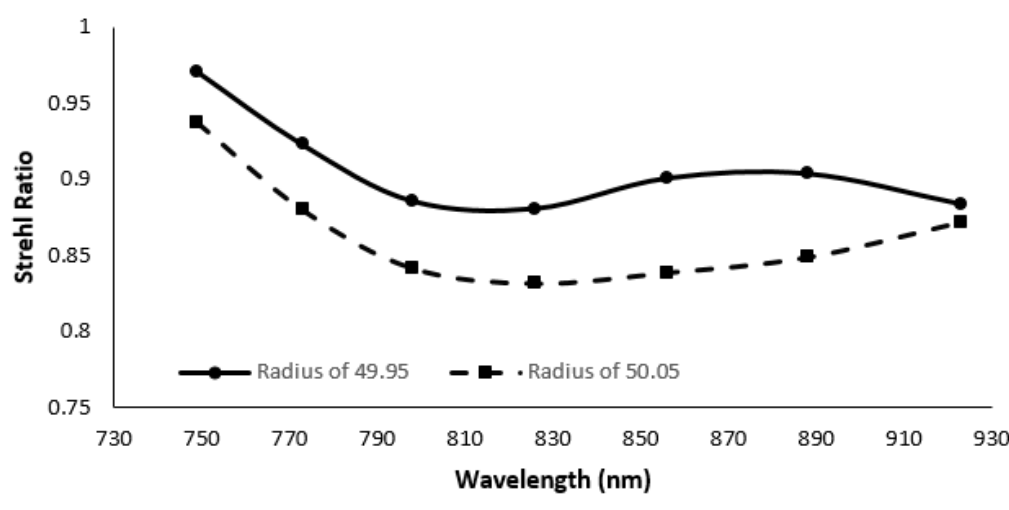
Figure 11. Strehl ratio of the proposed spectrometer for variation of cylindrical mirror angle.